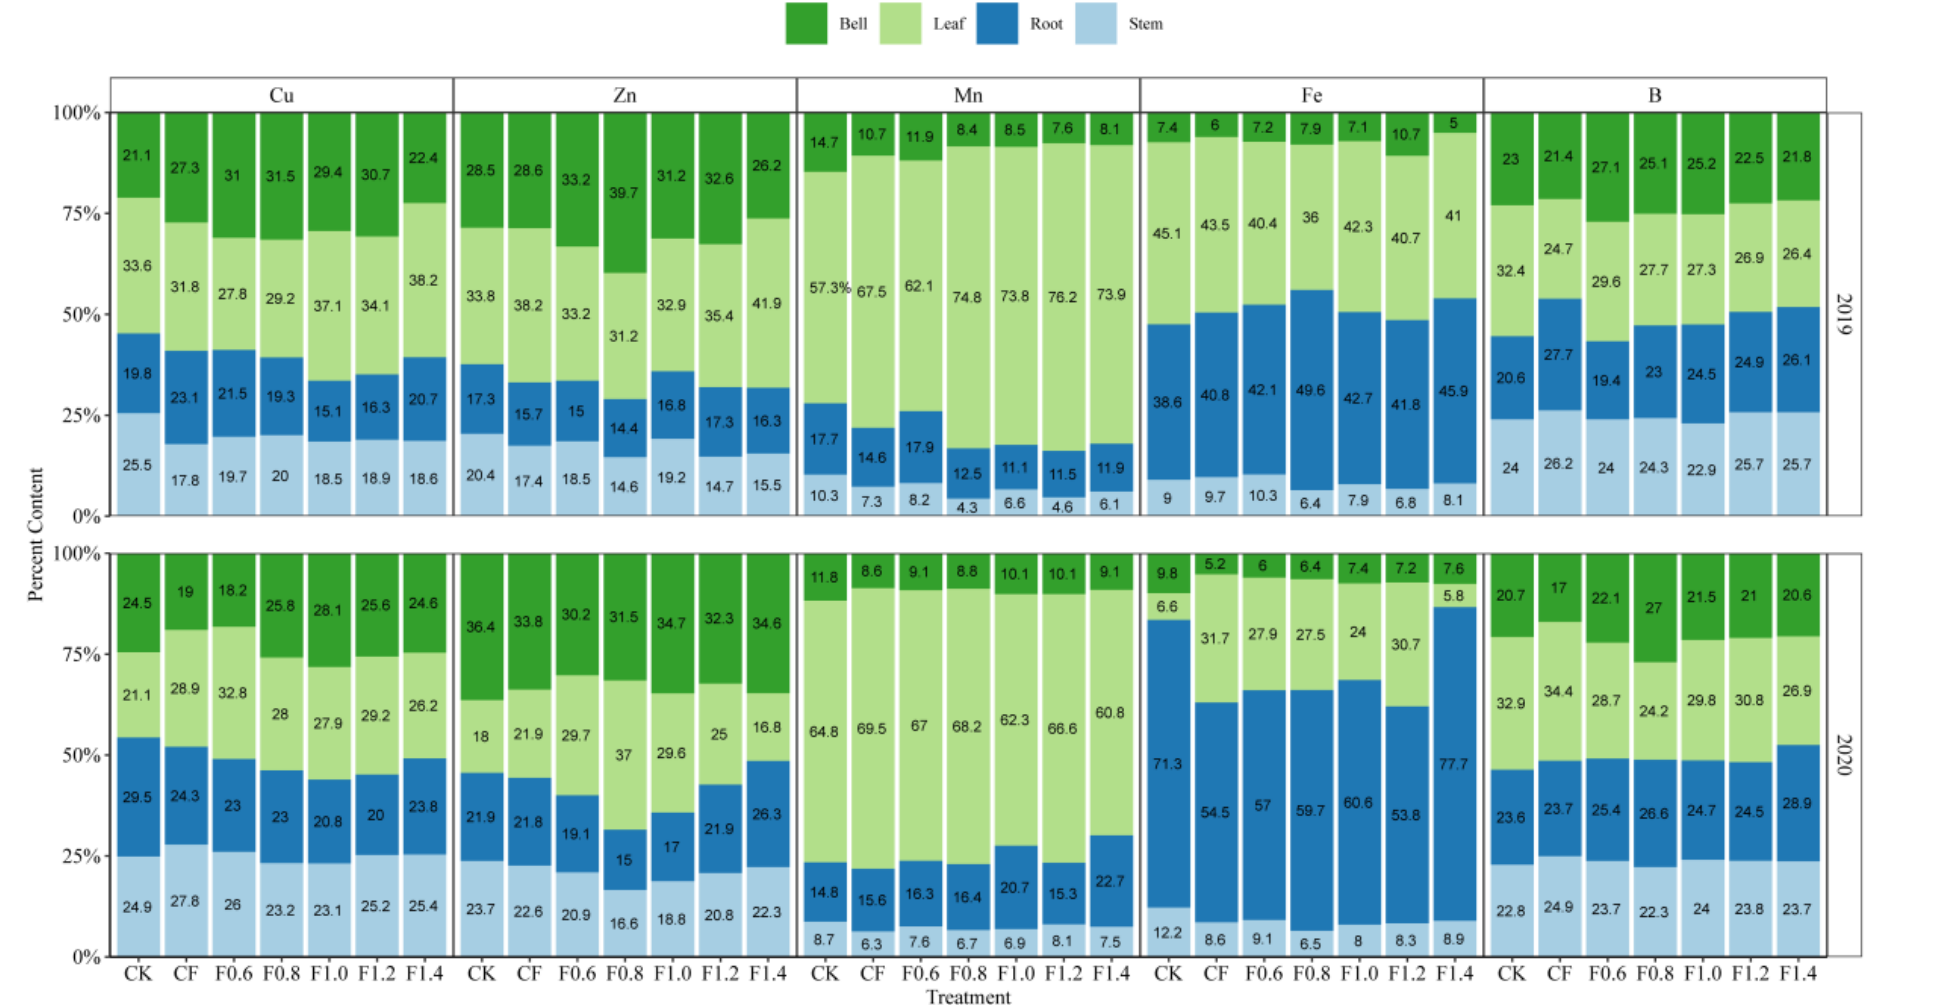
Figure 9. Changes in Cu, Zn, Mn, Fe and B distribution in cotton under different fertilization